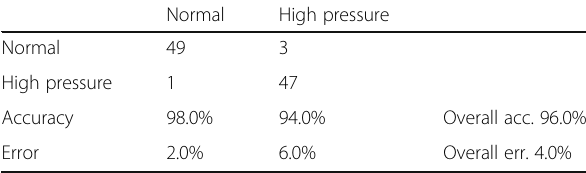
Table 5 Test confusion matrix for neural network Normal High pressure